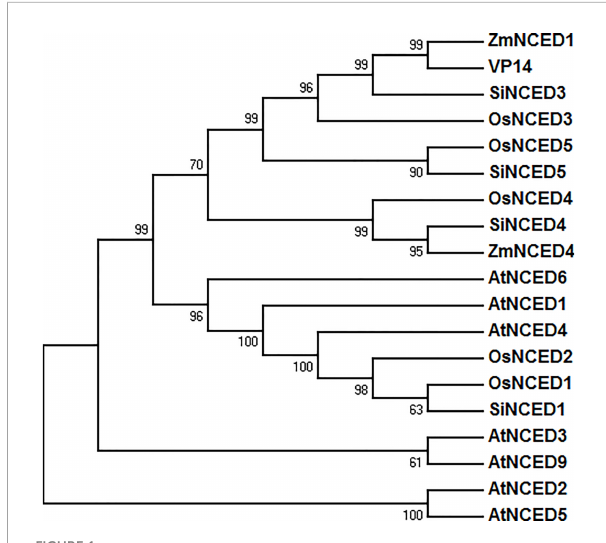
FIGURE 1 Phylogenetic tree analysis based on the amino acid sequences of SiNCED1 and other NCED from other plants. Nineteen amino acid sequences from four species were selected and analyzed by MEGA